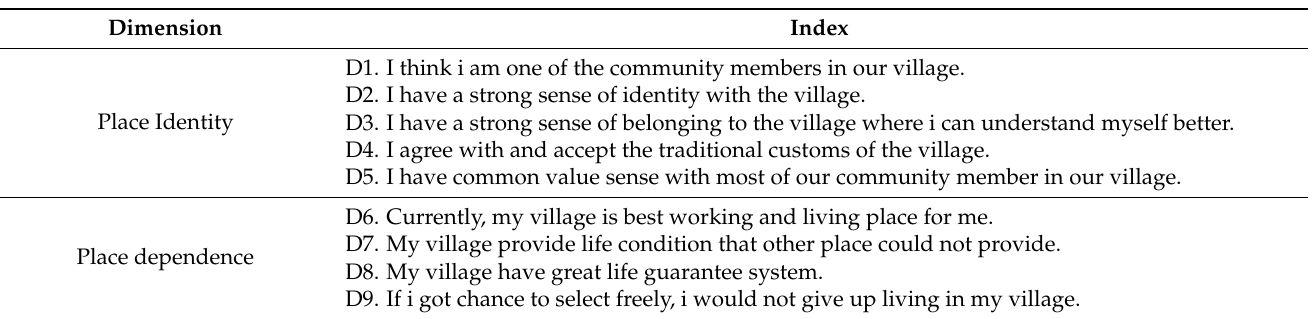
Table 5. Place attachment scale